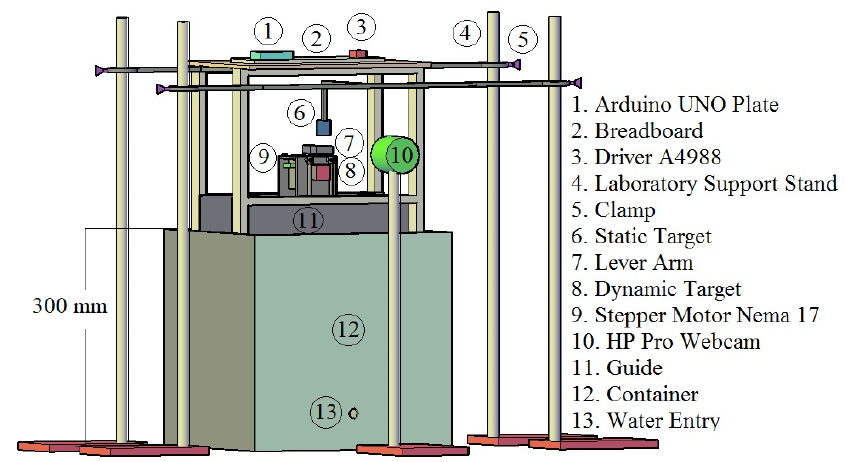
Figure 1. Schematic drawing of the experimental set-up.